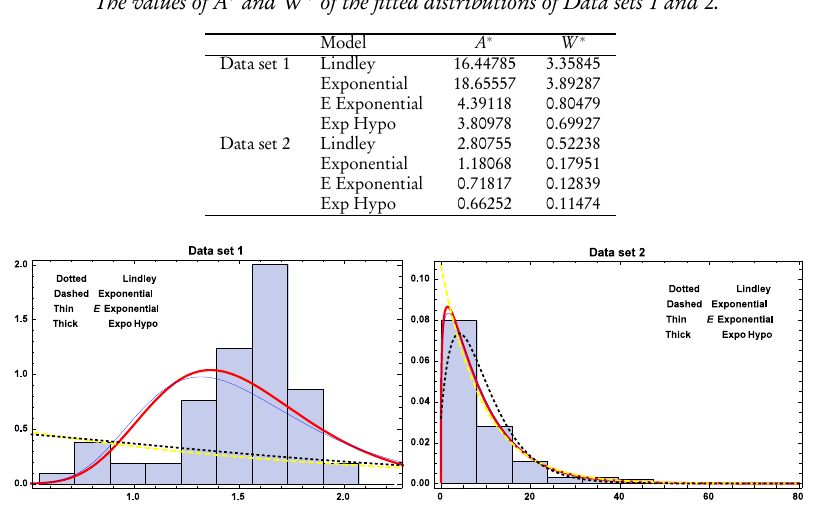
The values of A ∗ and W ∗ of the fitted distributions of Data sets 1 and 2.